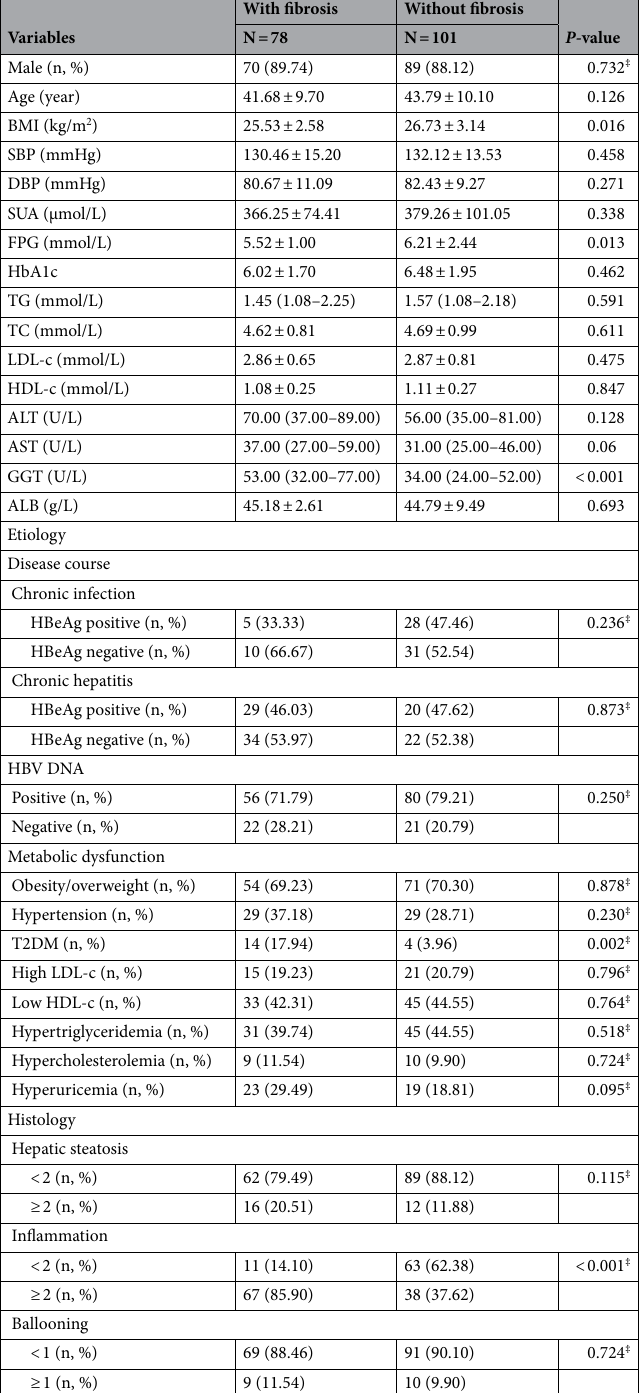
Table 3. Comparison of clinical characteristics among MAFLD patients with hepatitis B virus infection according to the presence of significant liver fibrosis. Data are expressed as mean ± standard deviation